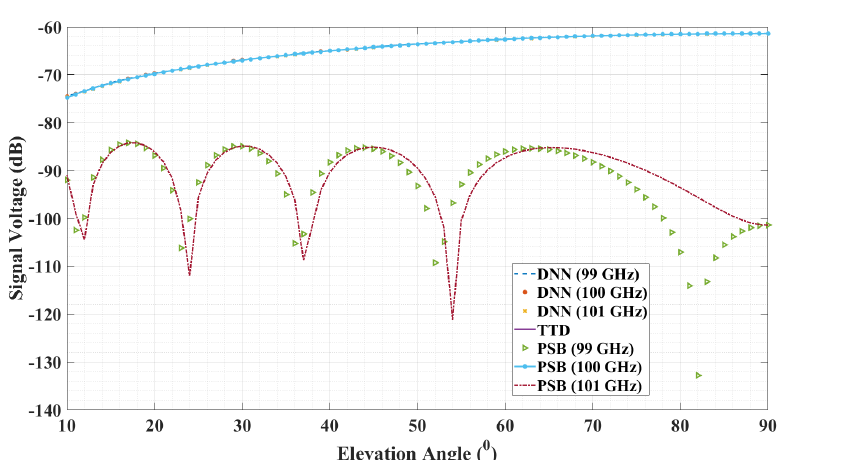
Figure 5. Performance comparison of PSB, TTD, and DNN Beamformer for the satellite elevation angle in the range of 10 ◦ to 90 ◦ at different frequencies of the wideband signal arriving at the antenna